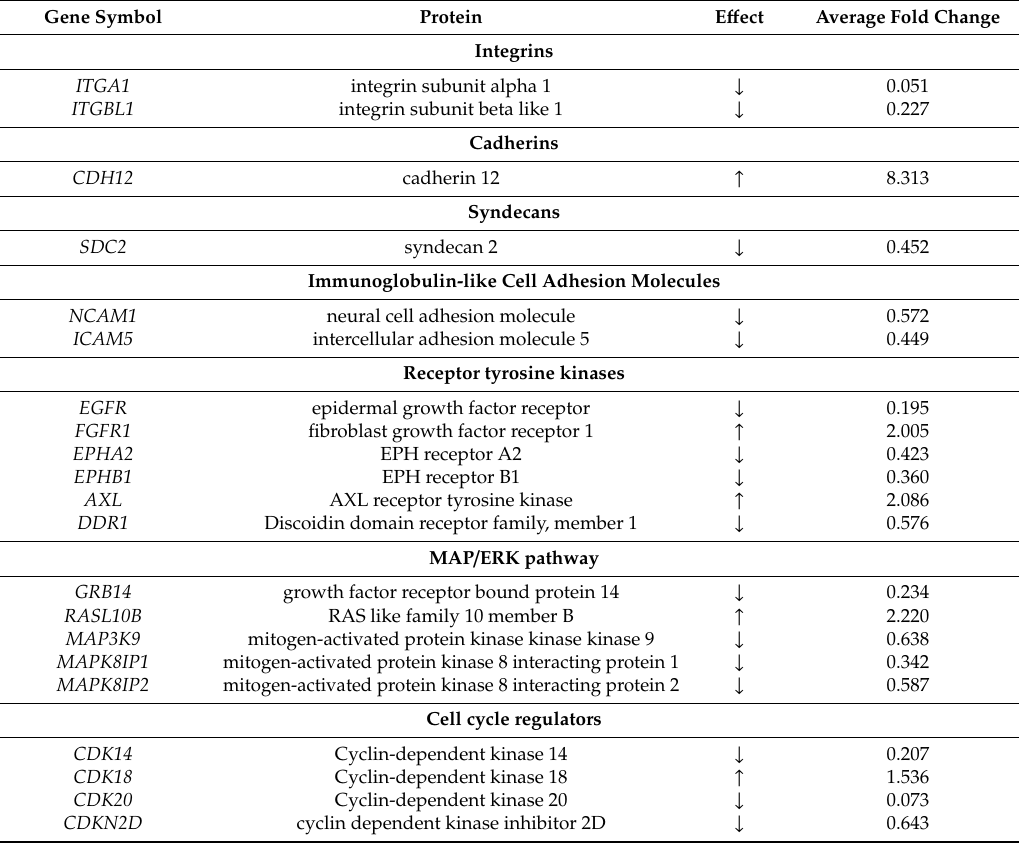
Table 2. Selected category of genes (based on a literature search) with changes in expression in MDA-MB-435S cells with SIRT2 downregulation as determined using